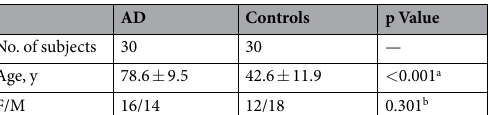
Table 2. Demographic and clinical profiles of AD patients and control groups. Abbreviations: AD = Alzheimer Disease. The data are presented as mean ± SD. a p values were calculated using two-tailed Student’s t test. b p values were calculated using chi-square